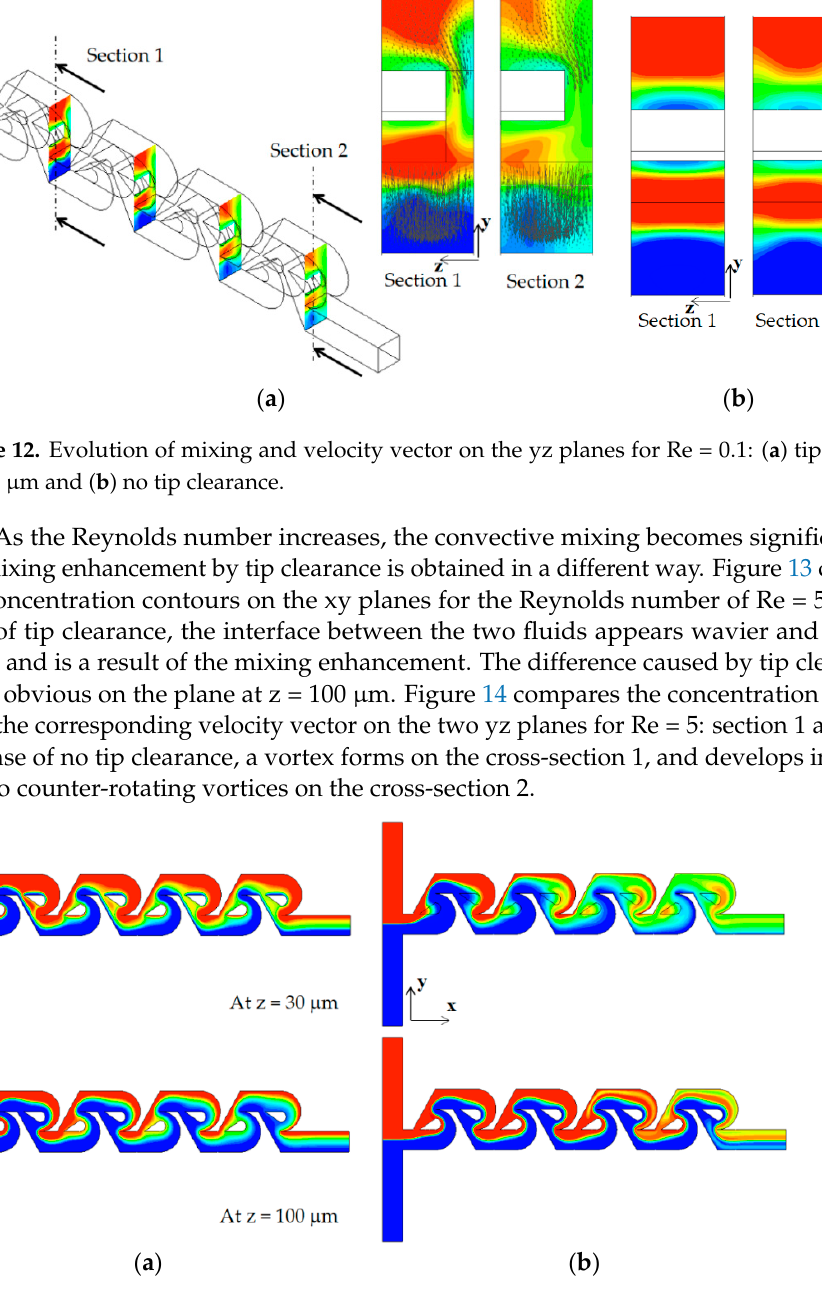
Figure 11. Comparison of concentration contours on the xy planes for Re = 0.1: ( a ) no clearance and ( b ) with tip clearance h = 60 μ m.